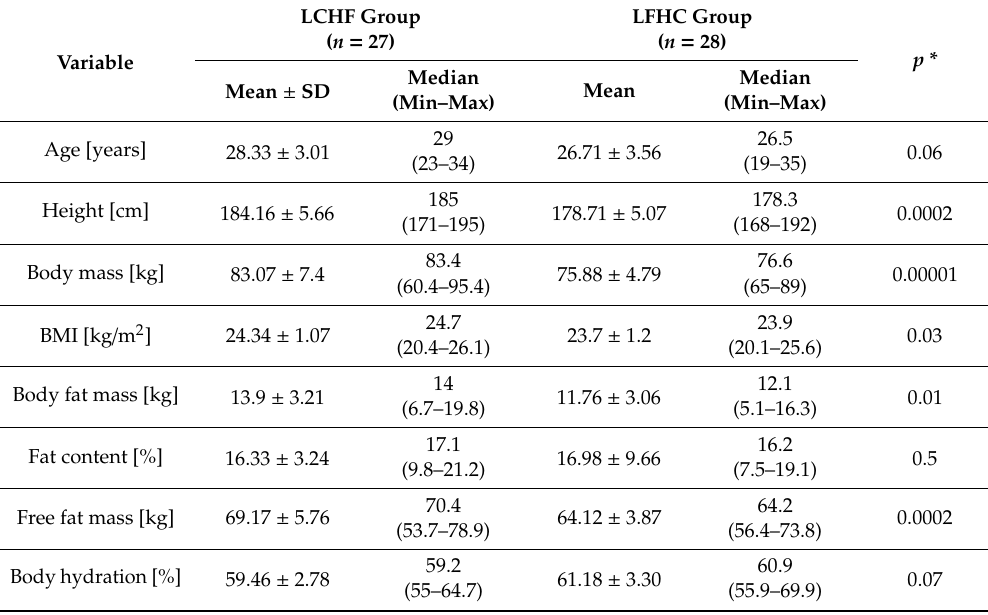
Table 3. Characteristics of groups at the early stage of the research.